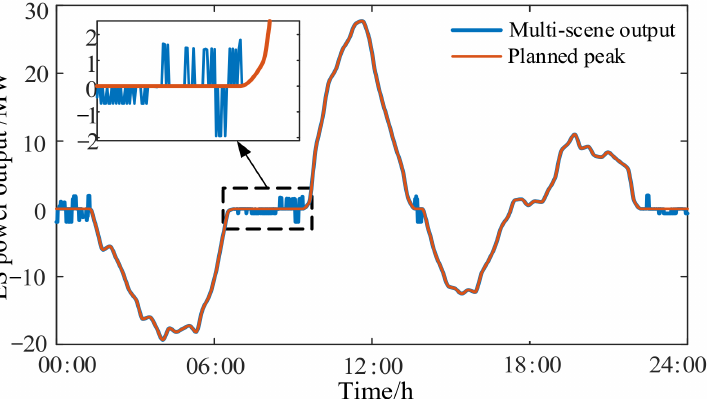
Figure 11. ES output in multiple peak and FM scenarios.